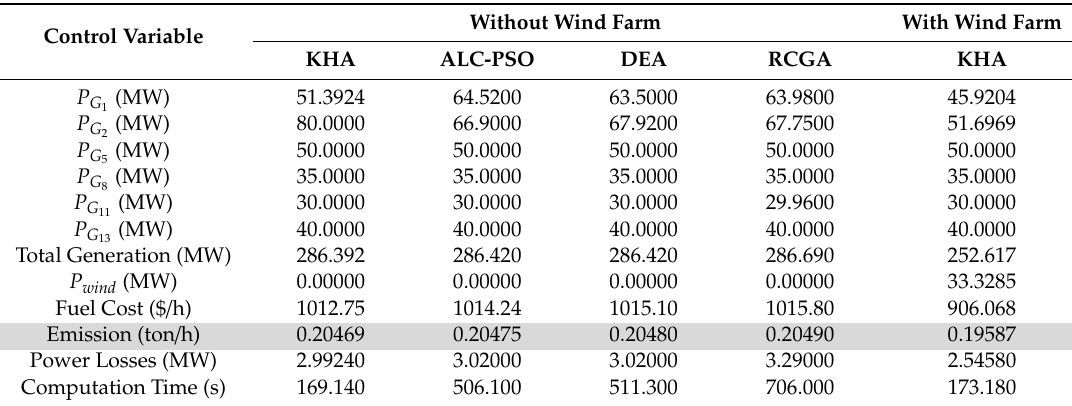
Table 6. Results for emission minimization for the Test System